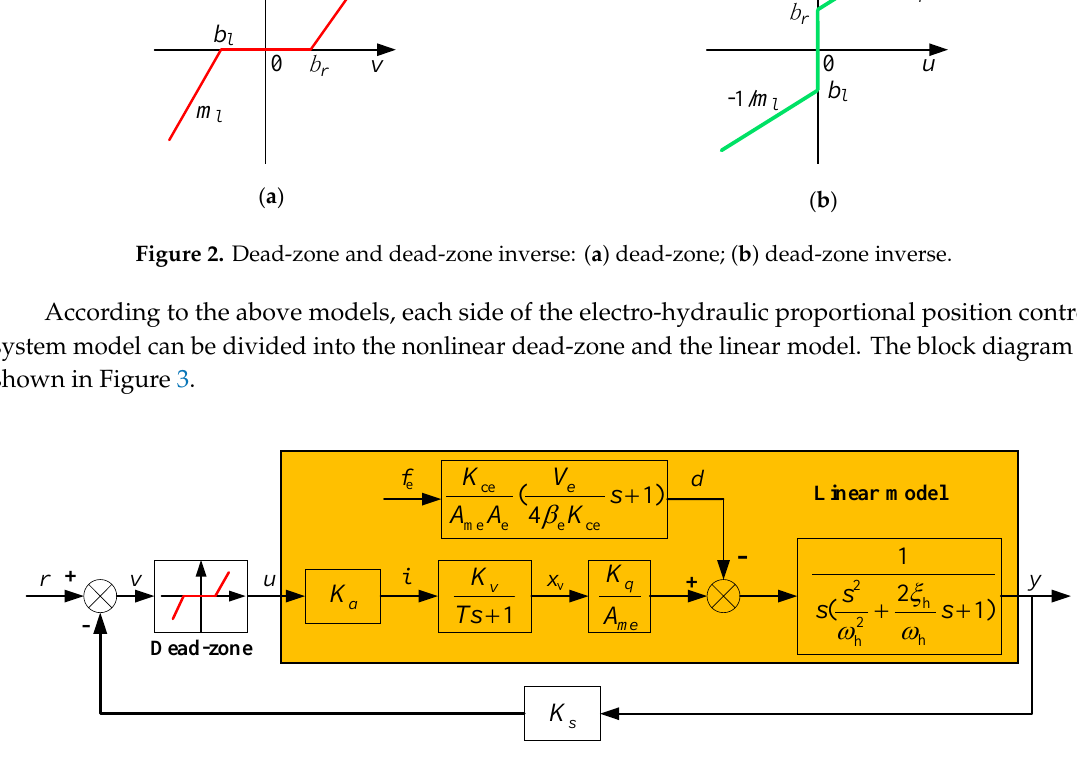
Figure 3. Block diagram of the electro-hydraulic proportional position control system.